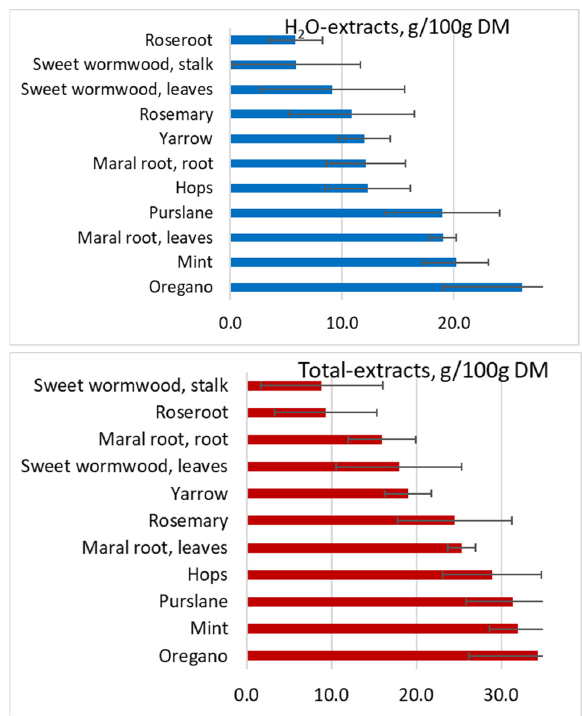
Figure 3. Eleven herbal extracts arranged by increasing yields (g 100 g − 1 DM ± SD) for three sequential extraction steps: DCM ( green ) followed by EtOH ( yellow ) and H 2 O ( blue ). Total extraction yield of all three samples (DCM + EtOH + H 2 O) ( red ).